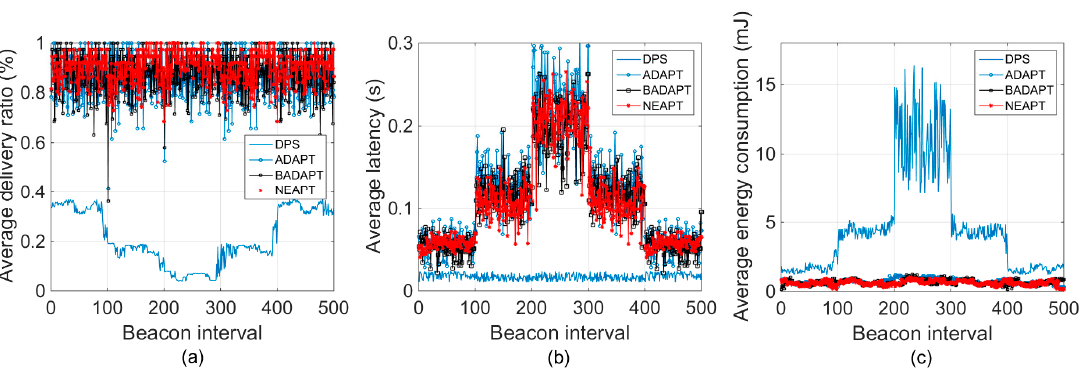
Figure 5. Delivery ratio, latency and energy consumption under dynamic conditions. ( a ) Delivery ratio. ( b ) Average latency. ( c ) Energy consumption.